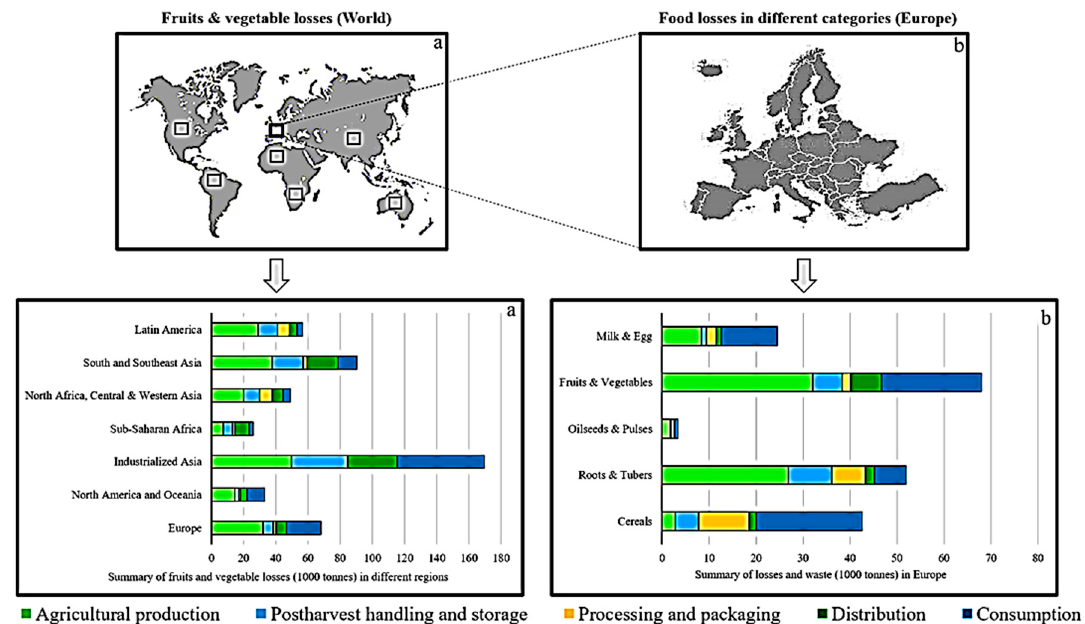
Figure 2. Food wastes: Global and European context. ( a ) global fruit and vegetable losses ( b ) food losses in different categories across Europe (adapted from [13]).